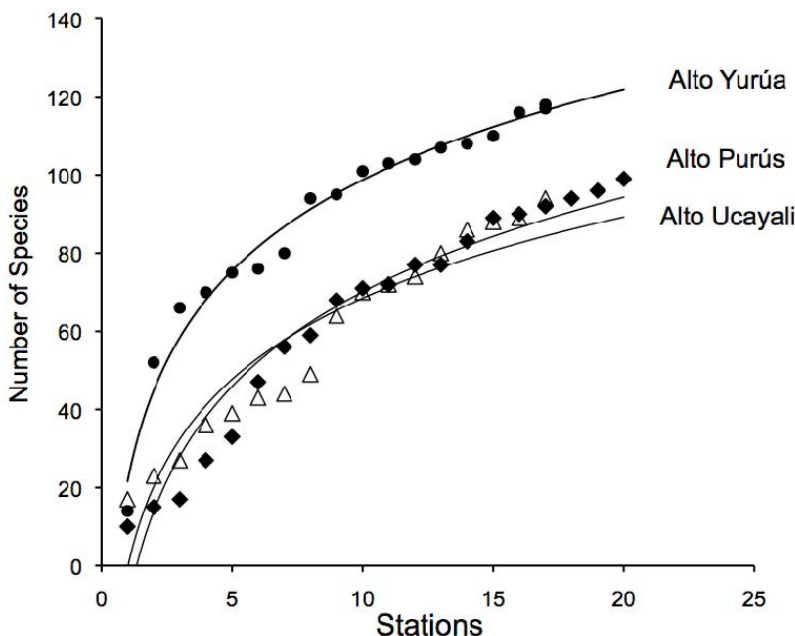
Figure 2. Accumulation curves of fish species collected in three expeditions to the interior drainages of the Fitzcarrald Arch, Peru. Each expedition involved about 20 field days during the period of low water (July) in the Alto Yurúa (2008), Alto Ucayali (2009) and Alto Purús (2010) basins. Note the accumulation curves do not approach asymptotic